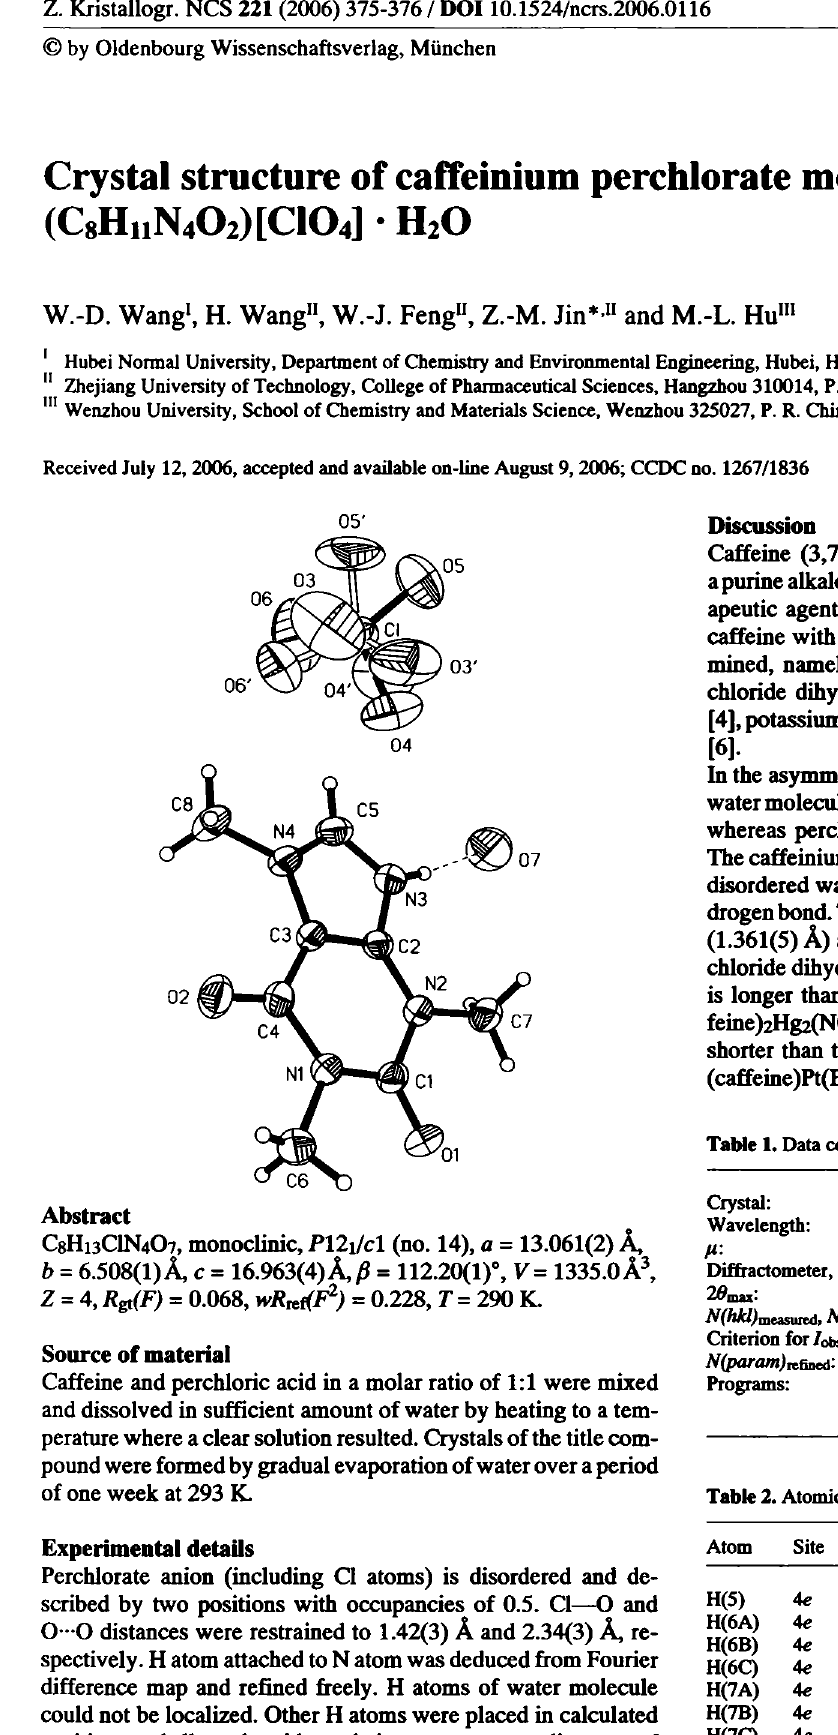
Table 2. Atomic coordinates and displacement parameters (in A 2